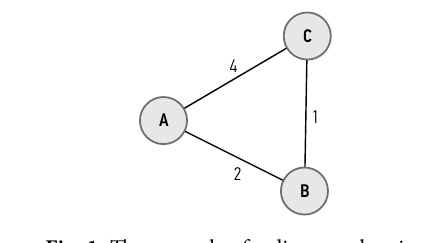
Fig. 1. The example of a diagram showing the predefined costs of